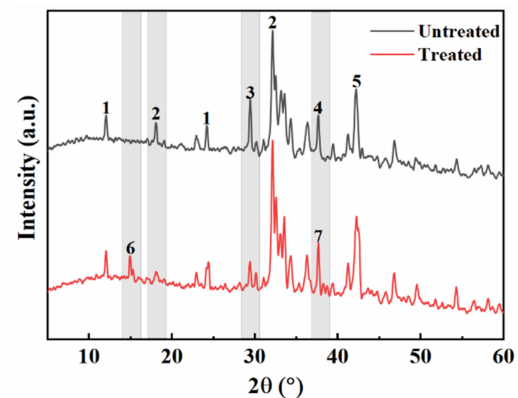
Figure 12. Comparison of mineral composition of steel slag (1—Ca 2 Fe 2 O 5 ; 2—Ca 2 SiO 4 ; 3—Ca 3 SiO 4 ;